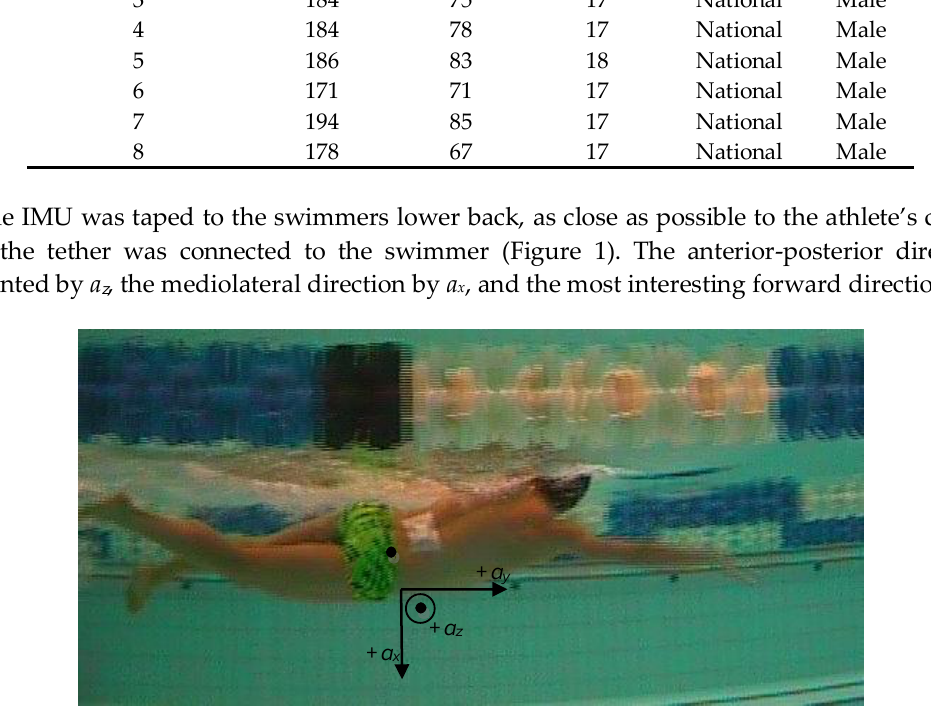
Figure 1. IMU taped to the athlete with the coordinate system in regards to the